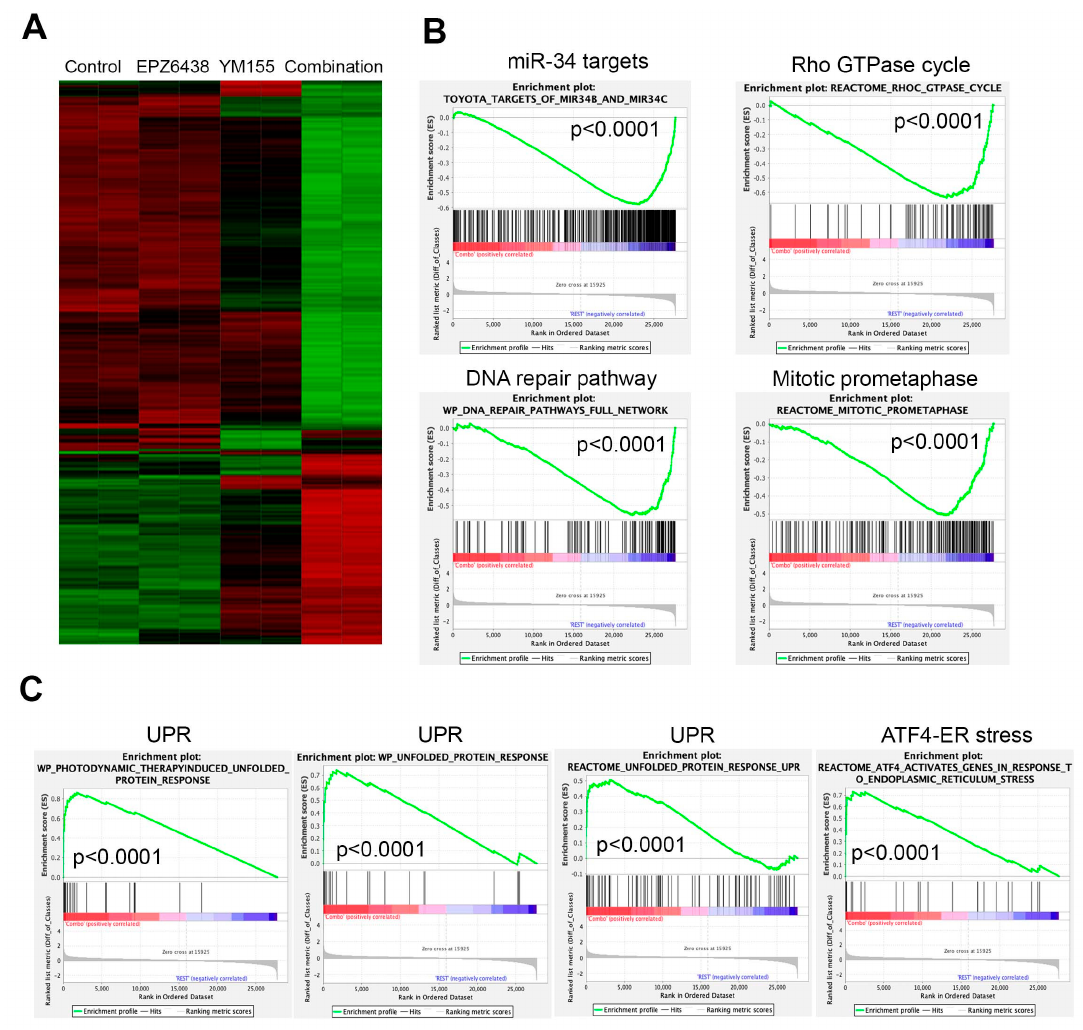
Figure 5. Combination of EZH2 inhibitors with YM155 perturbs multiple essential signaling path- ways. ( A ) Hierarchical clustering analysis of genes altered after 12 h treatment of BE2C cells with 5 µ M of EPZ6438, 5 nM of YM155, or combination. ( B ) Gene set-enrichment analysis shows gene signatures and pathways downregulated by combination of EPZ6438 and YM155 after 12 h treatment. ( C ) Gene set-enrichment analysis shows gene signatures and pathways upregulated by combination of EPZ6438 and YM155 after 12 h